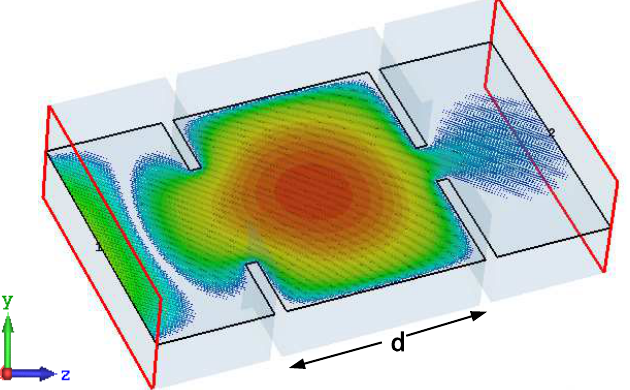
Figure 2. Electromagnetic energy stored in the rectangular waveguide resonator for X-band WR-90 with dimension a = 22.86 mm and b = 10.16 mm at center frequency 10 GHz with length